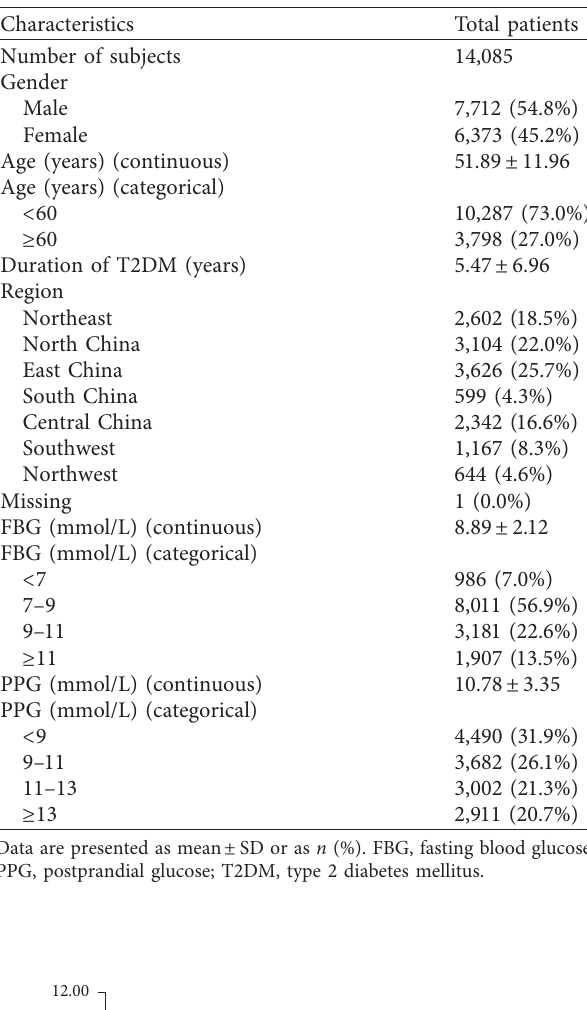
Table 1: Patient characteristics at baseline.